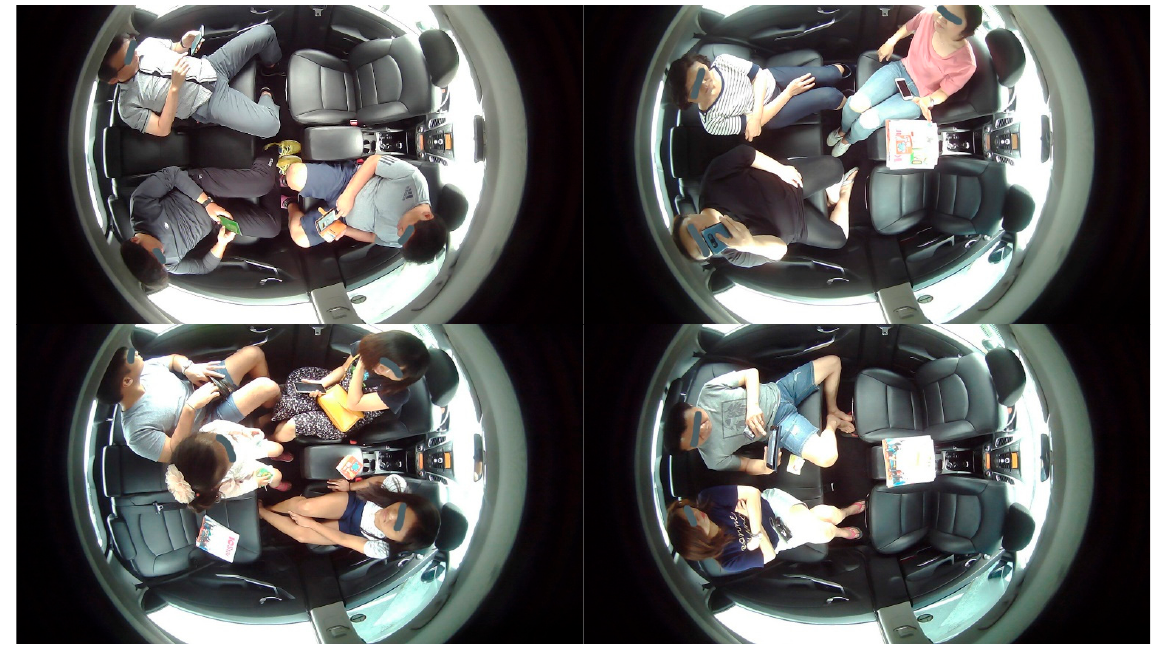
Figure 6. Illustrations are the datasets captured for cellular and electronic devices in the cabin of a vehicle. Here, some of the devices are in use, while others are unused.